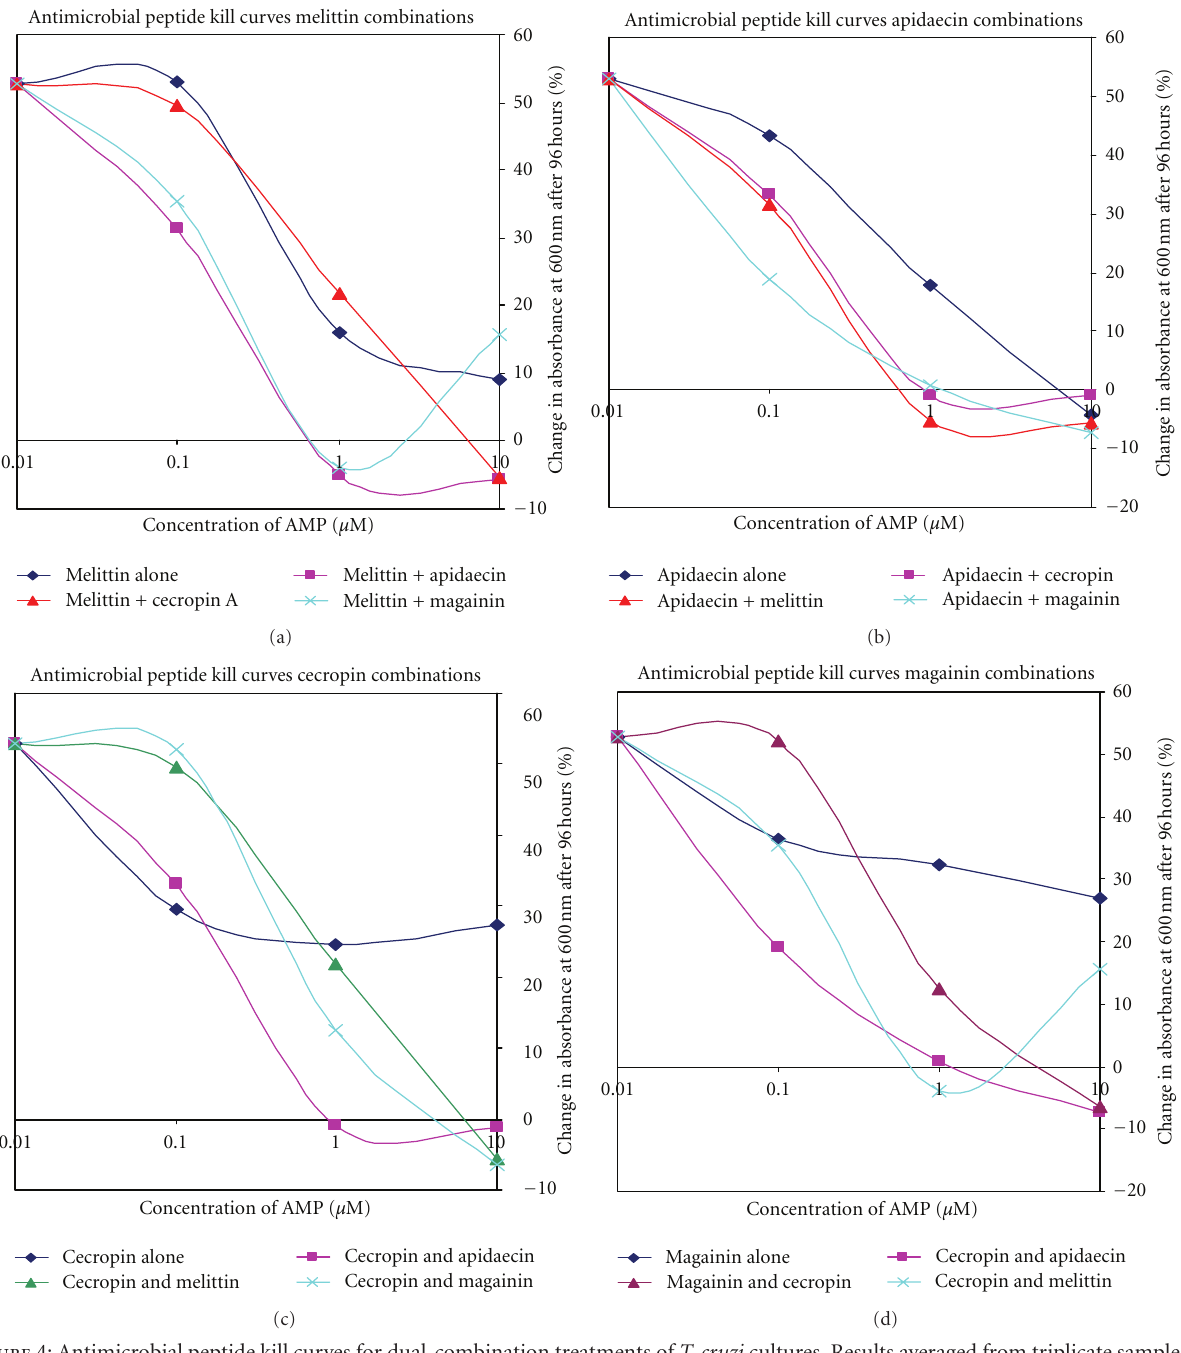
Figure 4: Antimicrobial peptide kill curves for dual-combination treatments of T. cruzi cultures. Results averaged from triplicate samples in three separate experiments and displayed as the percent change in absorbance at 600nm compared to untreated controls. Figure is adapted from Fieck et al. Trypanosoma cruzi : synergistic cytotoxicity of multiple amphipathic antimicrobial peptides to T. cruzi and potential bacterial hosts